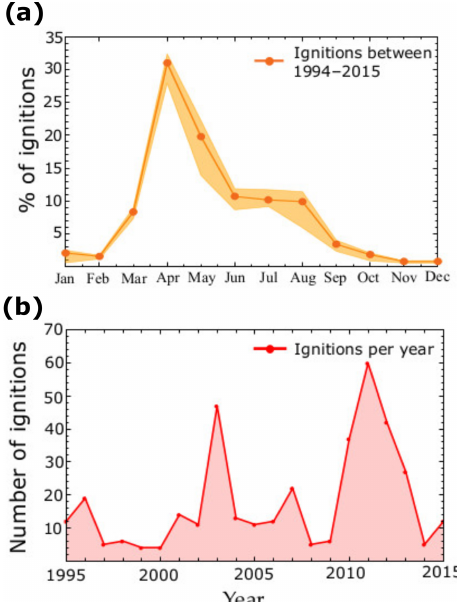
Figure 5. (a) The monthly relative ignition frequency between 1994 and 2015, and (b) the number of ignitions per